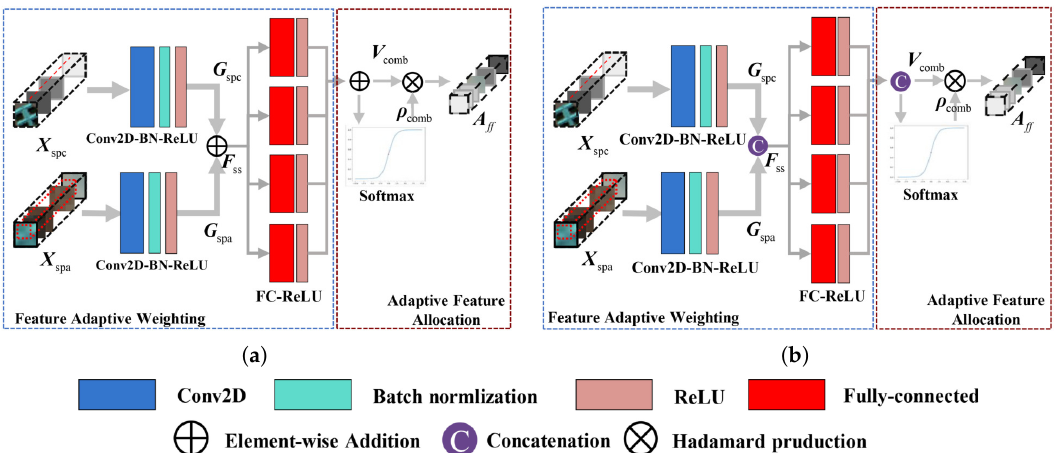
Figure 4. Adaptive weighting fusion models with ( a ) element-wise addition and ( b ) feature